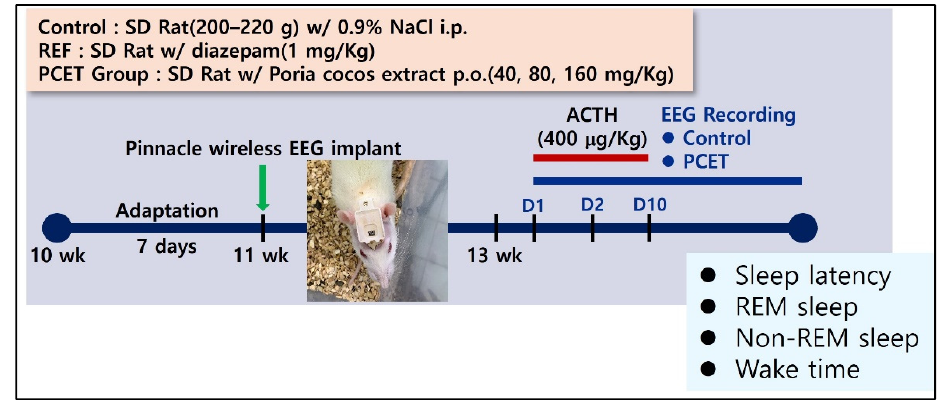
Figure 3. Building a continuous brainwave measuring animal model using a Pinnacle wireless EEG.